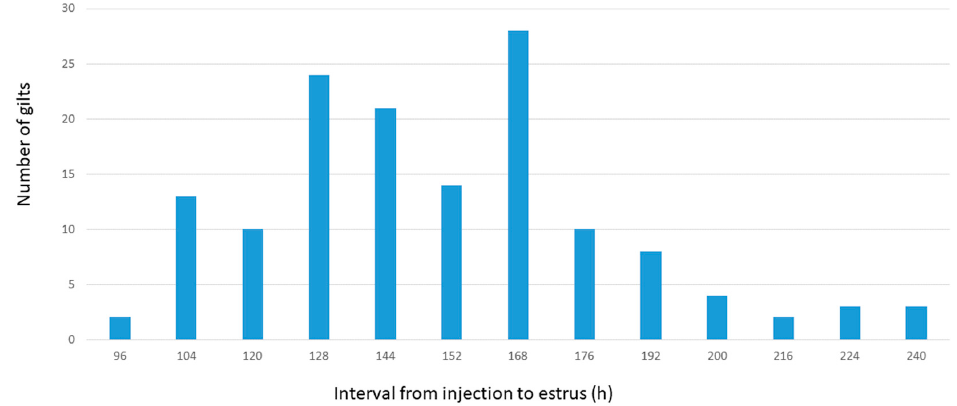
Figure 1. Distribution of intervals to estrus detection in gilts following injection of 400 IU eCG plus 200 IU hCG (PG600).